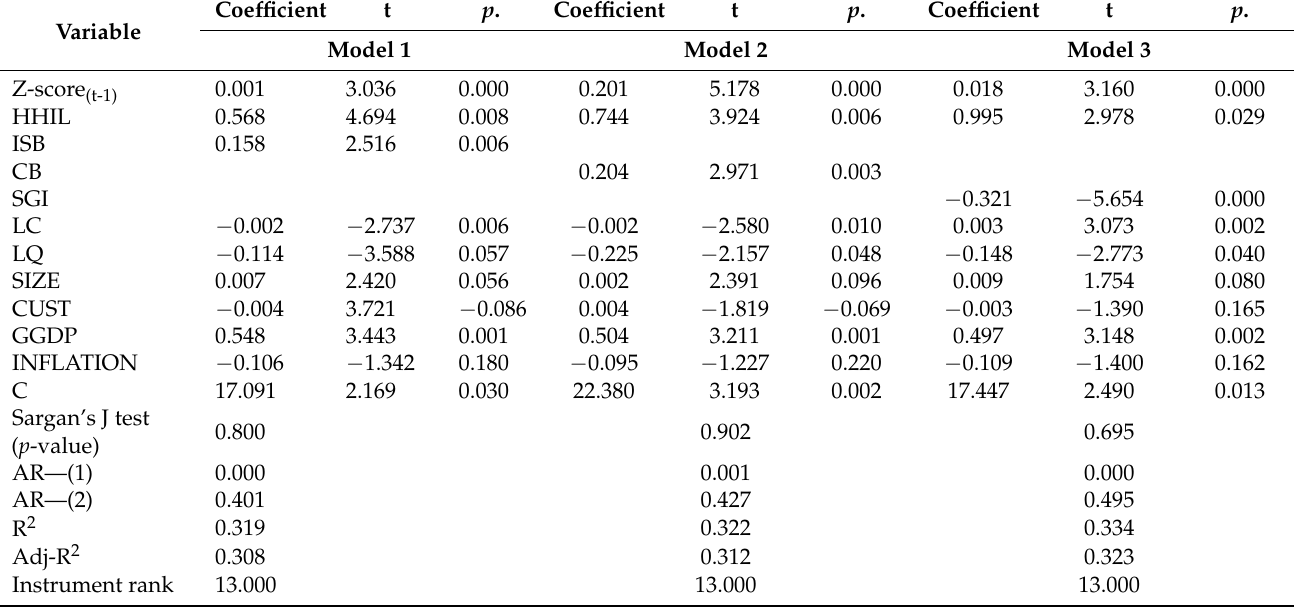
Table 10. Effects of competition (based on HHIL), loan quality and ownership structure on financial